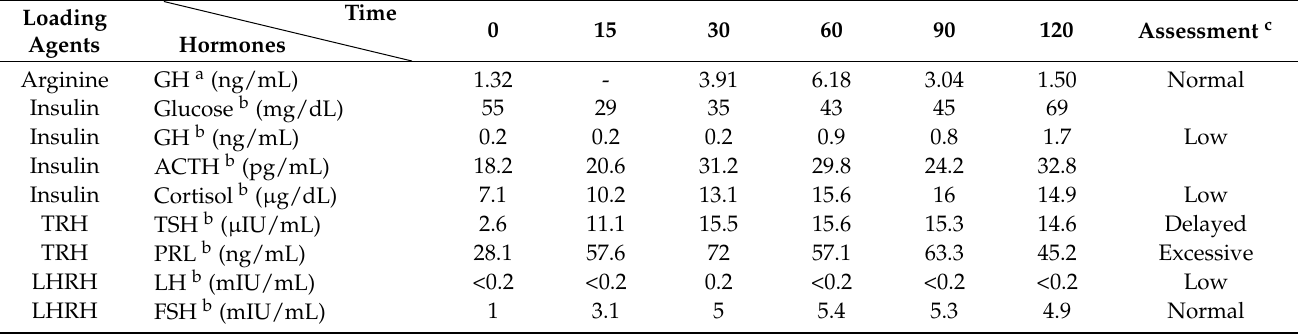
Table 1. The results of the anterior pituitary stimulation